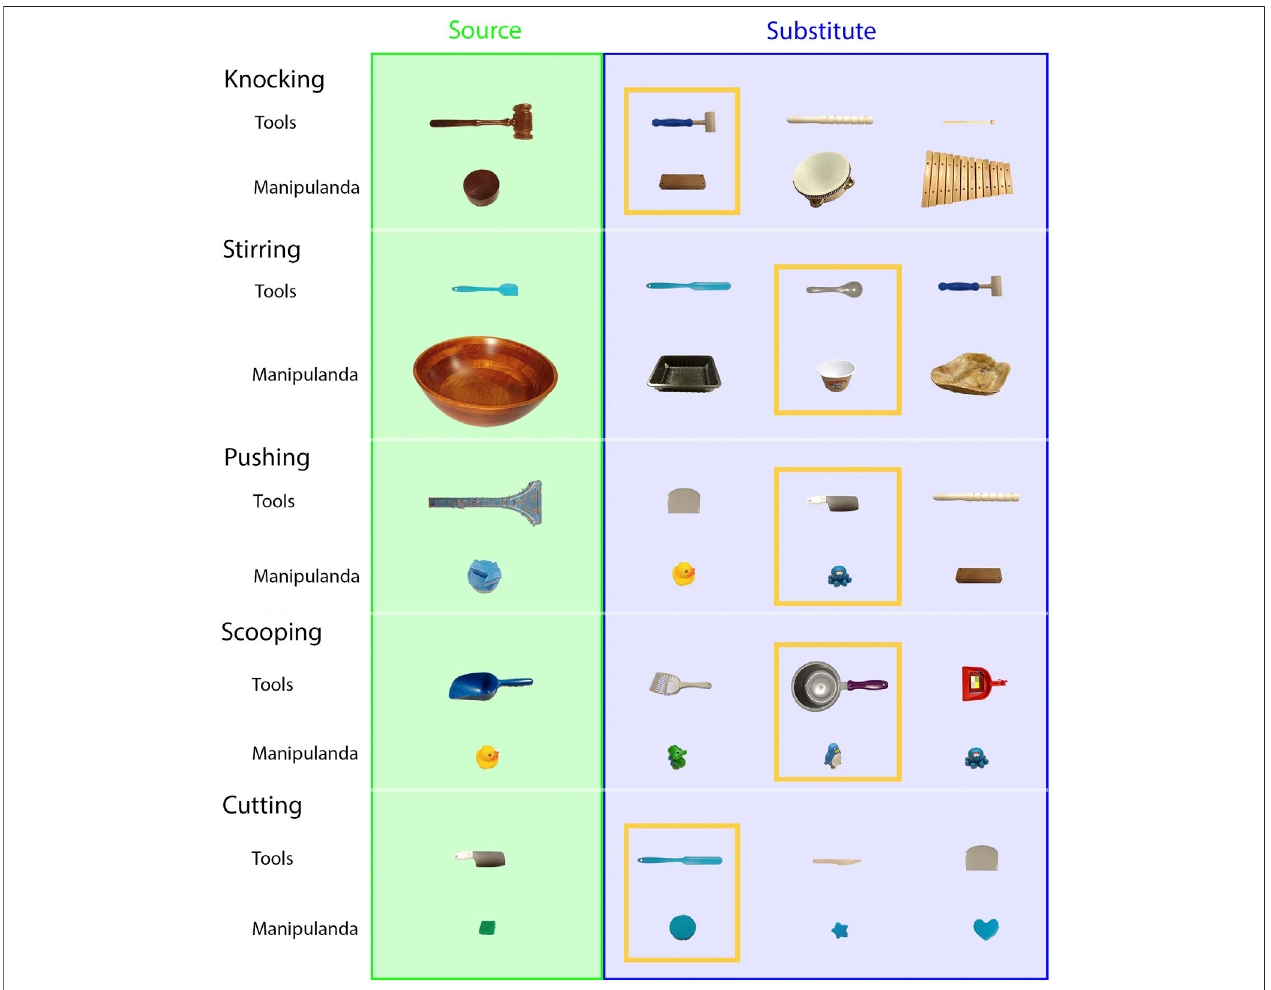
FIGURE 8 | Substitute objects (Star 2). For each task, that is, knocking, stirring, pushing, scooping, and cutting, three substitute tools and three substitute manipulanda were included in testing. The objects in the yellow frames were used as source objects in Star 3.